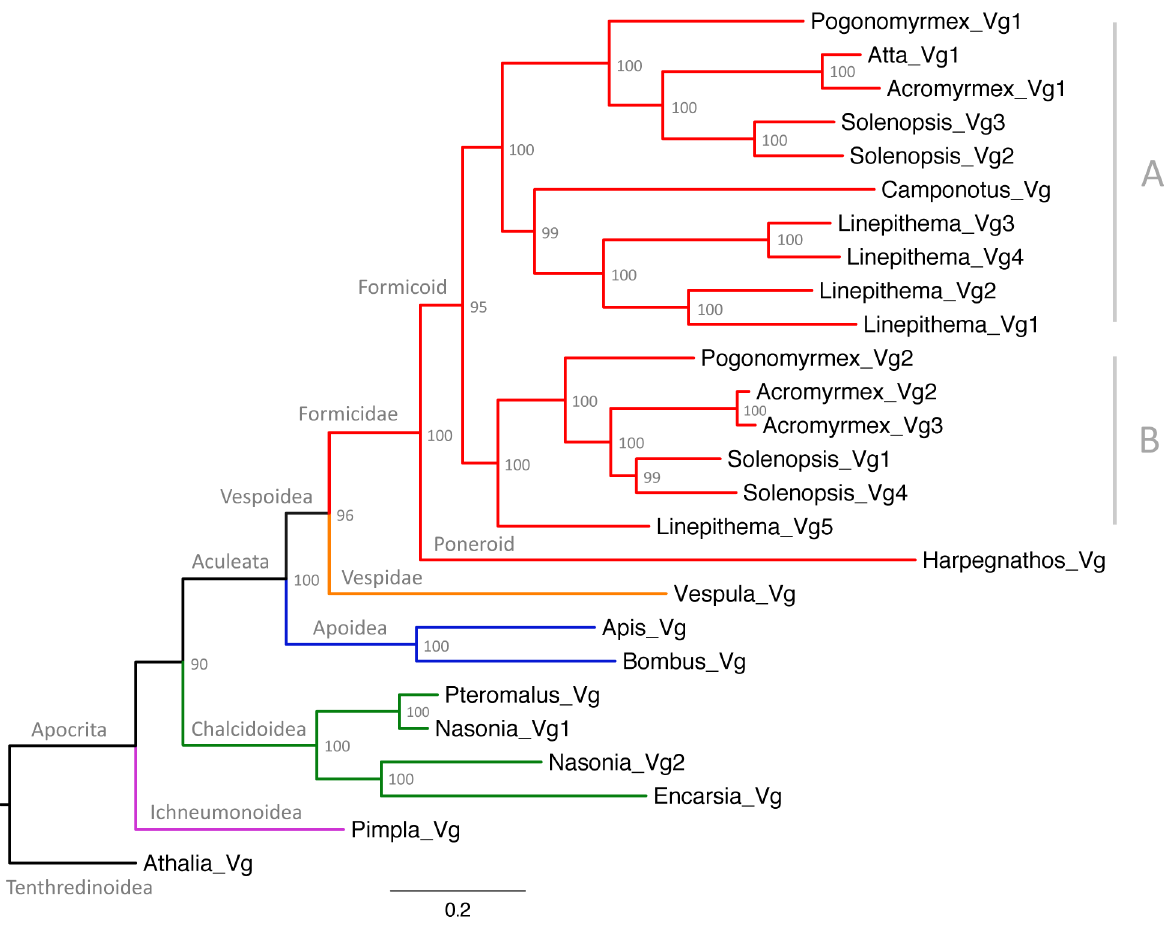
Figure 2. Maximum likelihood tree of ant vitellogenins. Vg sequences from species belonging to representative Hymenopteran groups are also included. Values at the nodes represent bootstrap support from 10,000 replicates. A and B represent different subfamilies of the formicoid clade.